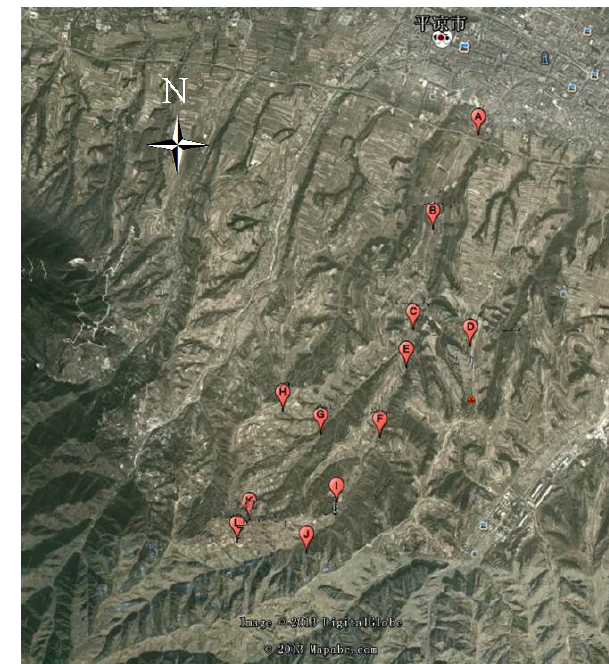
Figure 4. The spatial distribution of soil samples.